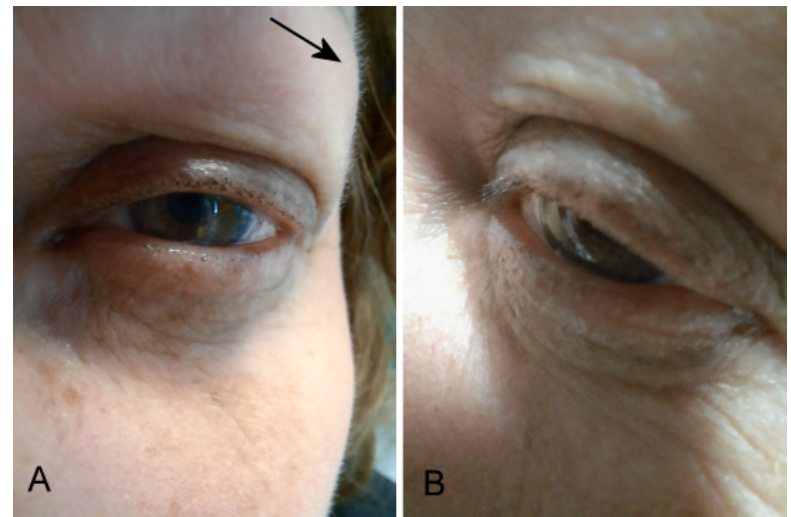
Figure 2: Left eye, A) facial hair regrowth (black arrow) and B) eyelashes